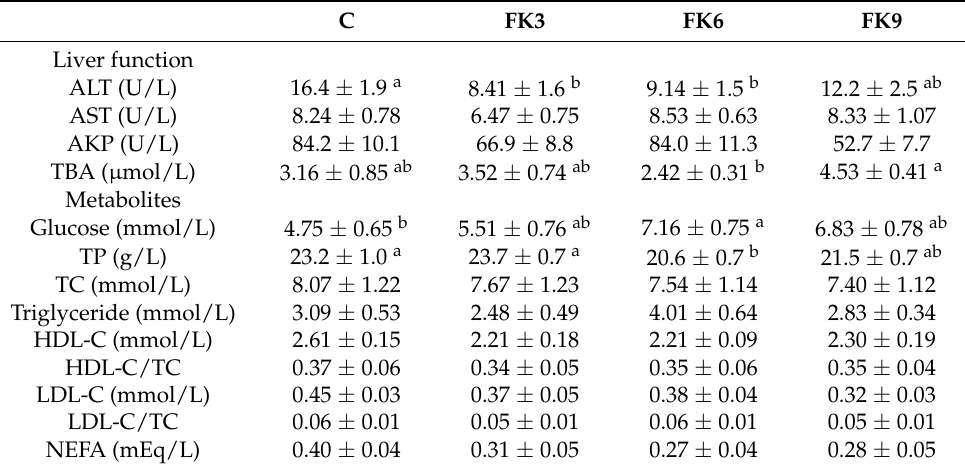
Table 7. Liver function and metabolites in plasma of largemouth bass fed diets with various FK levels (means ± SEM, n = 12).